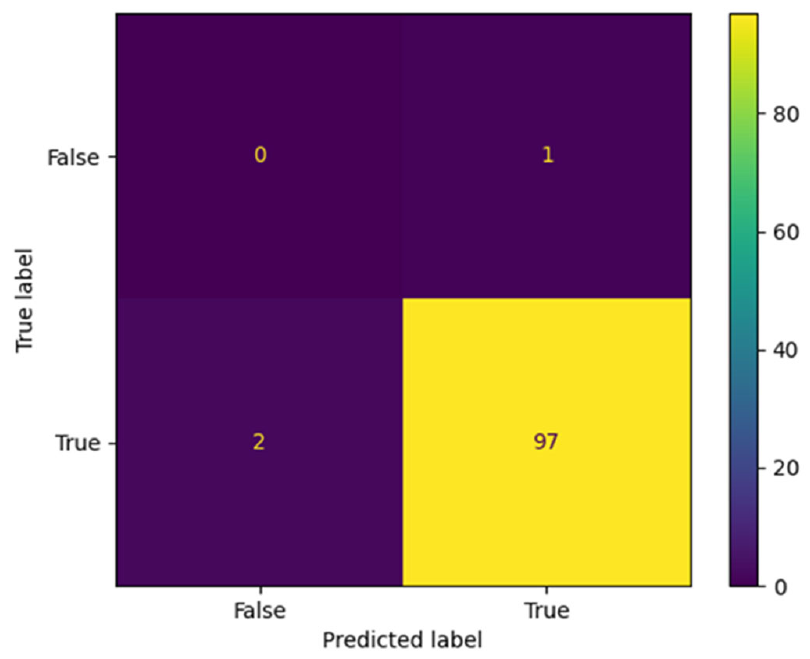
Figure 10. Confusion matrix obtained by AraBERT on the Zain dataset.